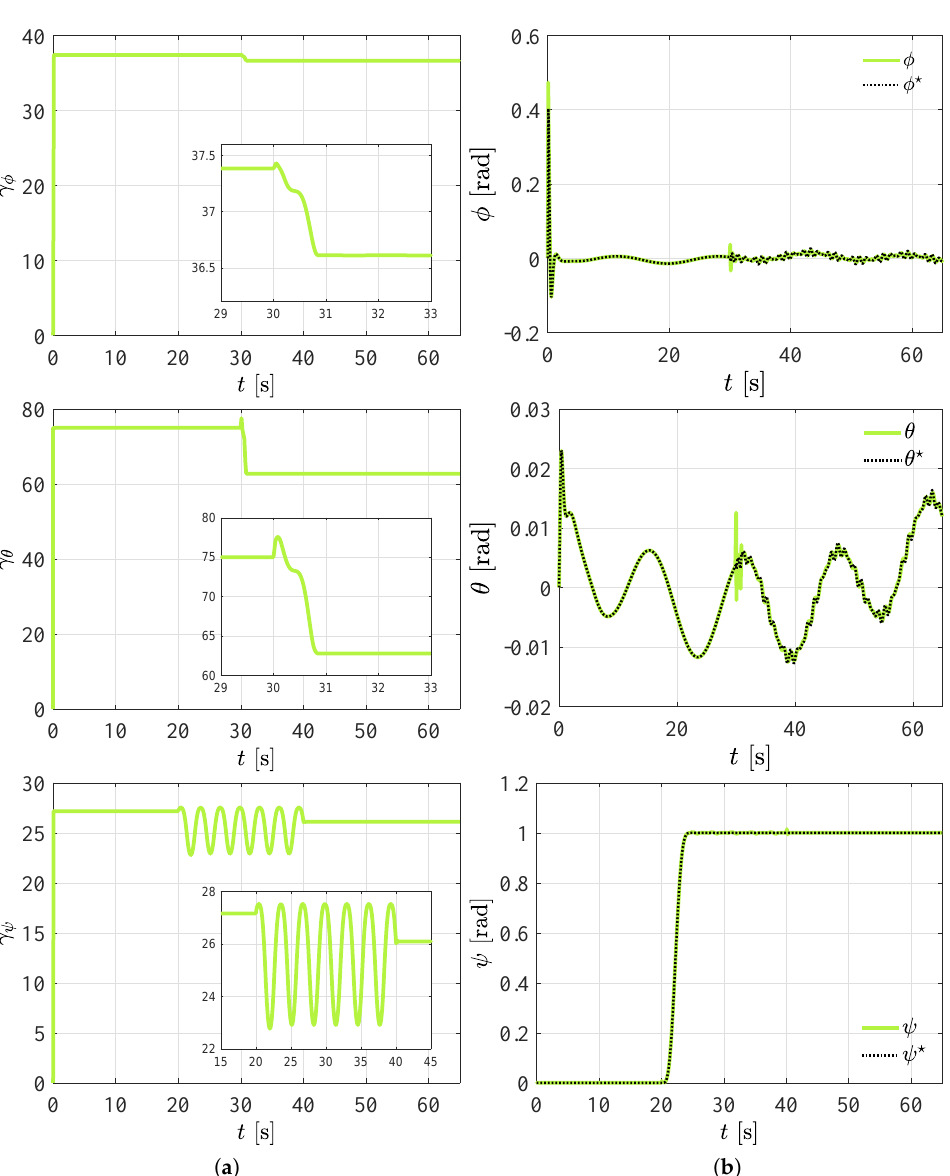
Figure 18. Dynamic rotational closed-loop response for the experiment 4: ( a ) Computed rotational adaptive control parameters. ( b ) Angular tracking